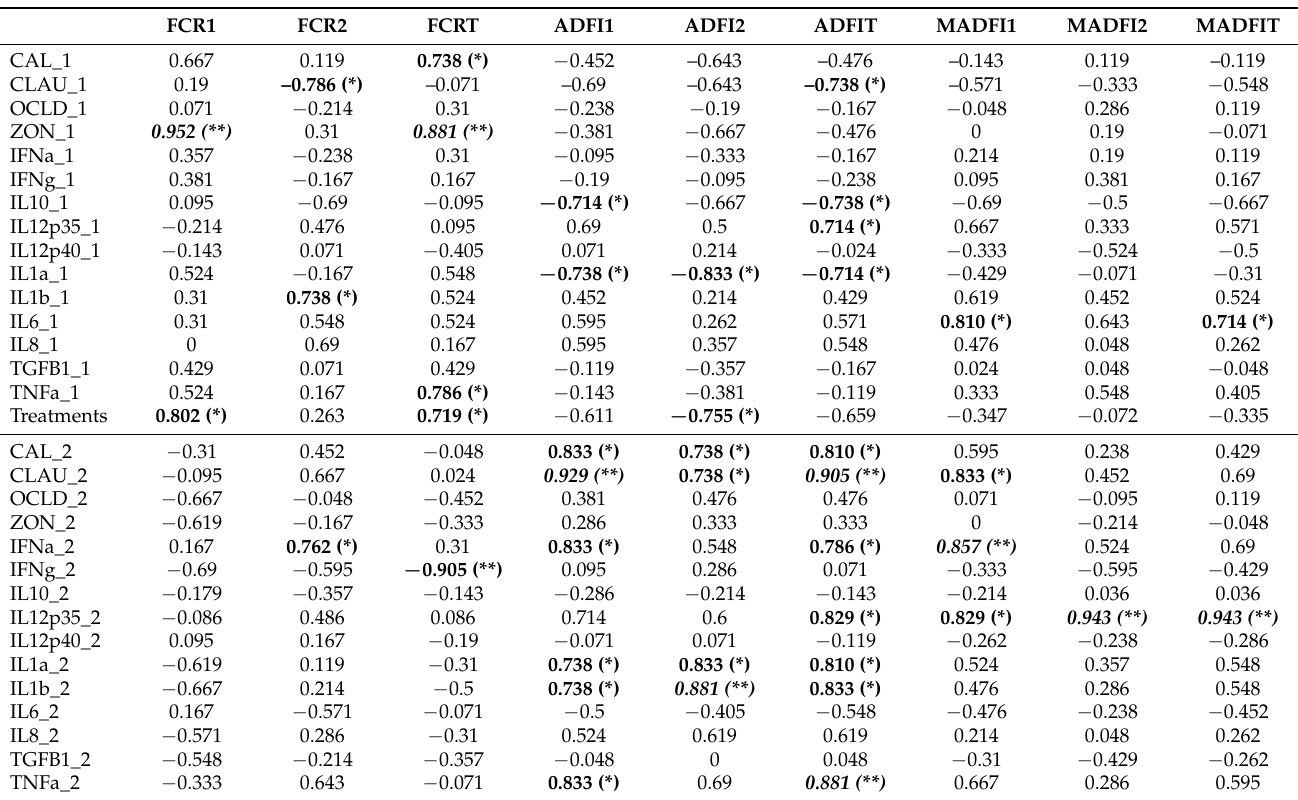
Table 7. Correlations among biomarkers in first fecal sampling and physical performances related to feed efficiency.